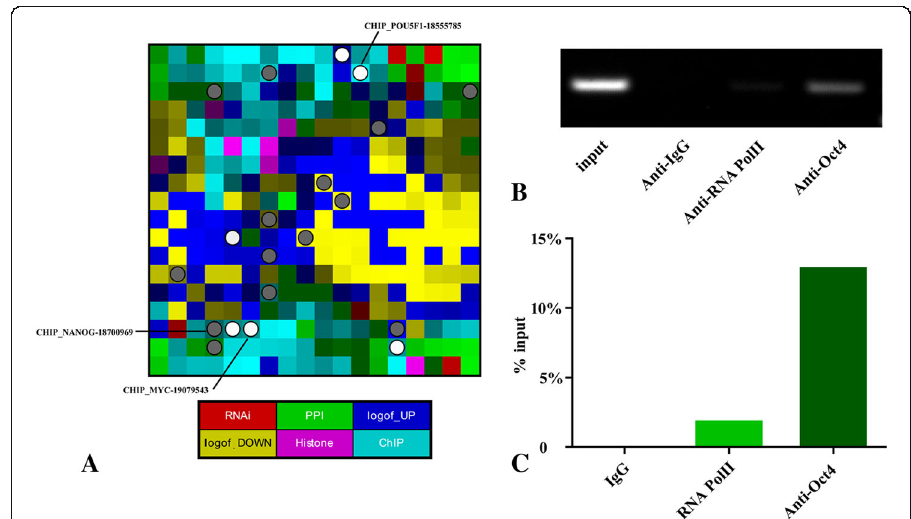
Fig. 3 The chromatin immunoprecipitation assay was conducted to confirm the binding of Oct4 to the promoter of mouse Dnmt1 in vivo. a Enrichment results for Dnmt1 determined via ChIP-Seq. The different colors indicate the experiment type, and each square represents a list. Enriched terms are highlighted in circles and three terms are annotated. The brightness indicates the level of local similarity between the lists. b Anti-RNA Pol II and anti-Oct4 antibodies precipitated proteins bound in vivo to the specific amplified sequence of the mouse Dnmt1 promoter (the region between − 554 and − 294 bp). Non-specific IgG (negative control antibody) failed to do. A 213-bp length